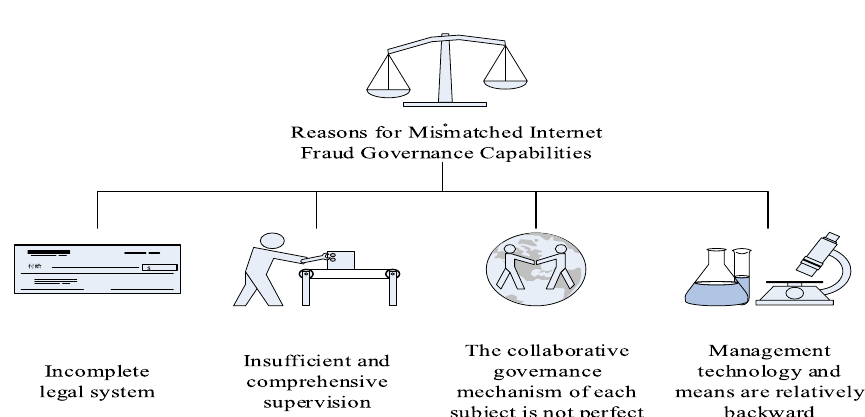
Fig. 13 Reasons for a mismatch in cyber fraud governance capabilities